Question: Write a caption explaining this figure to a reader.
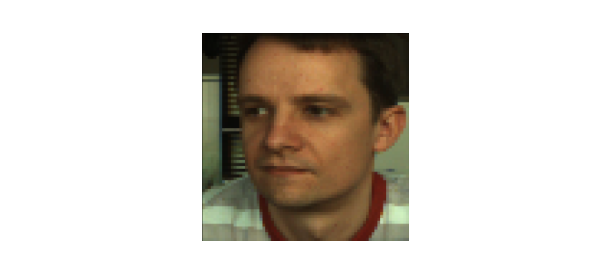
Answer: Frame of Subject 1 in scenario Medium Rotation from PURE [4] with dynamic cropping (×1.5-scale Box) and square padding applied. However, subsequent frames will remain cen- tered on the square padded and scaled facial region allowing for larger in-plane subject motion within a video sequence.